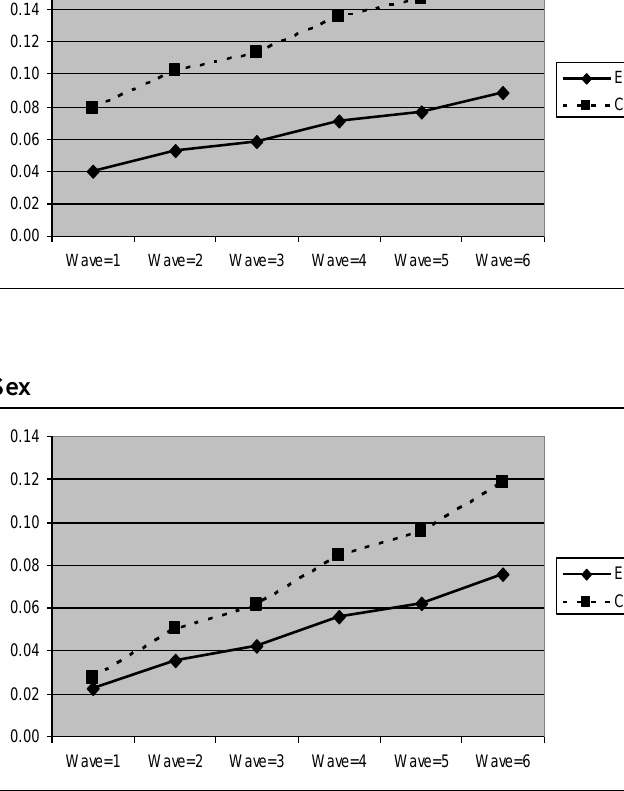
FIGURE 6 . Growth trajectories of the experimental group (participants who joined the Tier 1 Program only) and control group using the item score of run away from home as the outcome indicator.